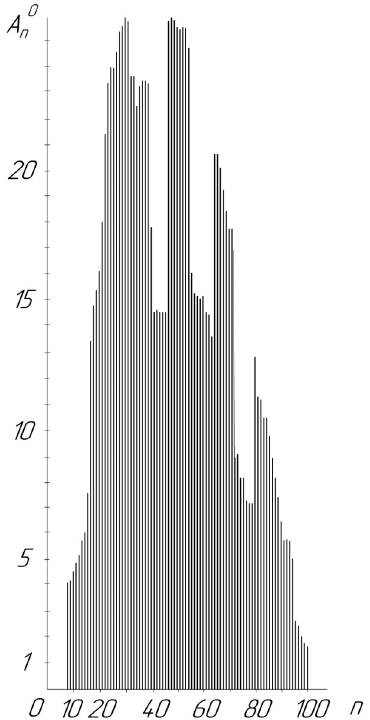
Figure 8. The rotor system spectrum with the number of places m = 59.